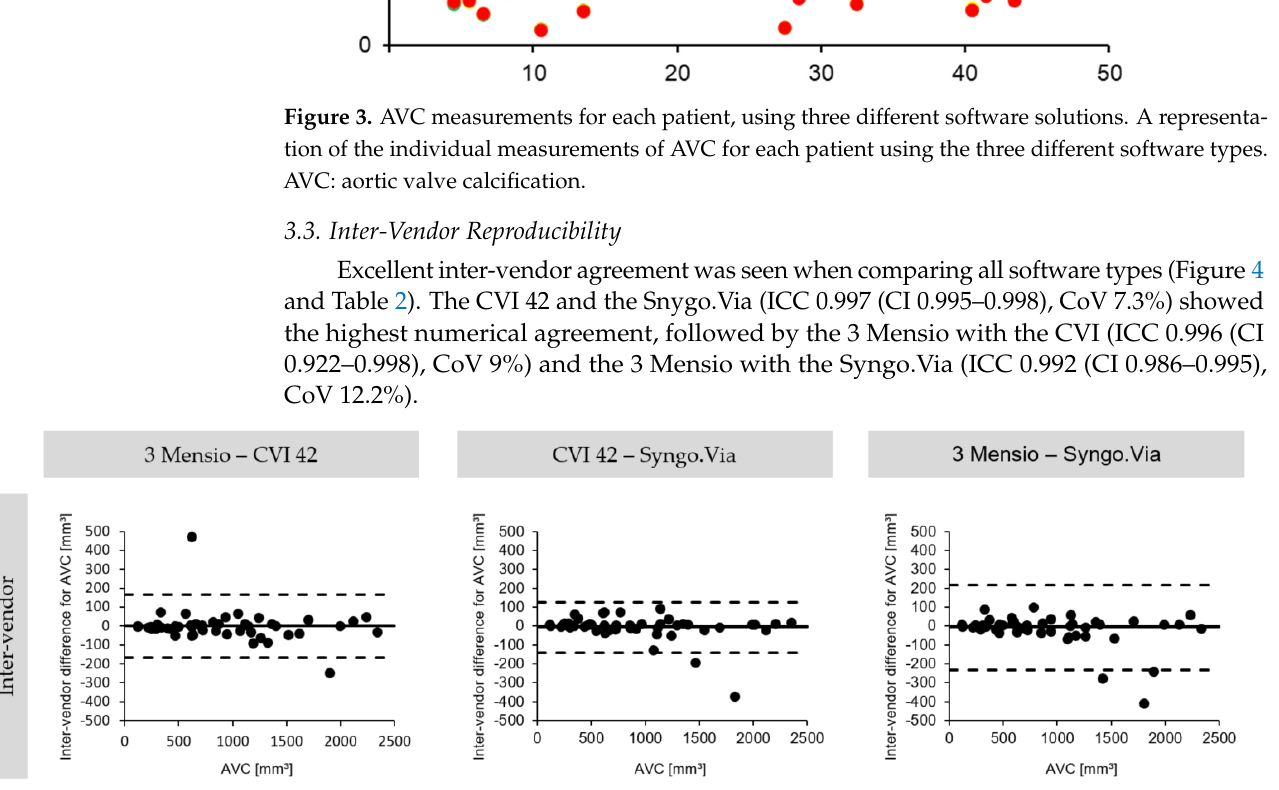
Figure 3. AVC measurements for each patient, using three different software solutions. A representation of the individual measurements of AVC for each patient using the three different software types. AVC: aortic valve calcification.